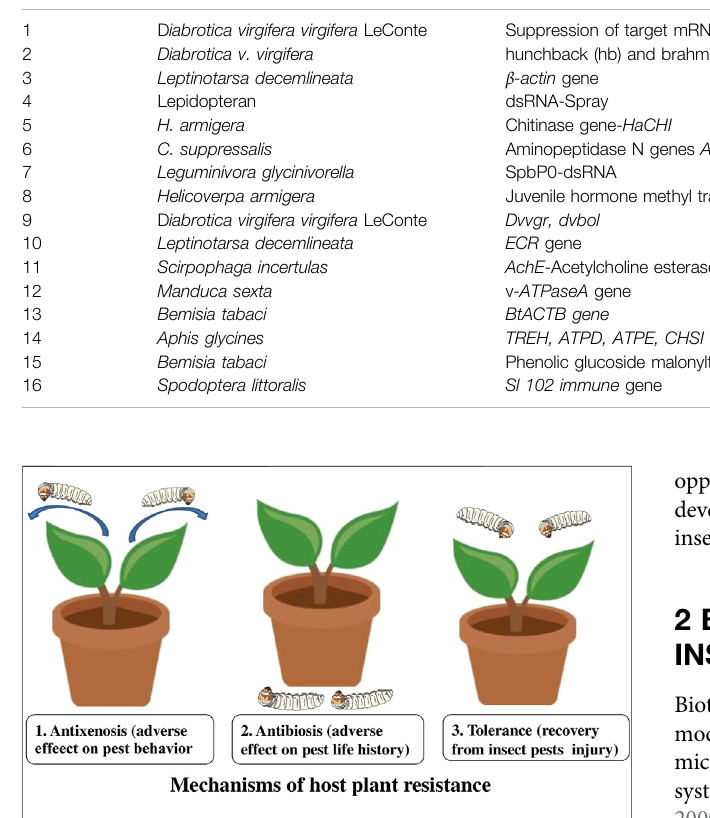
TABLE 6 | Transgenic crops for insect resistance through RNA interference. Sr. No.